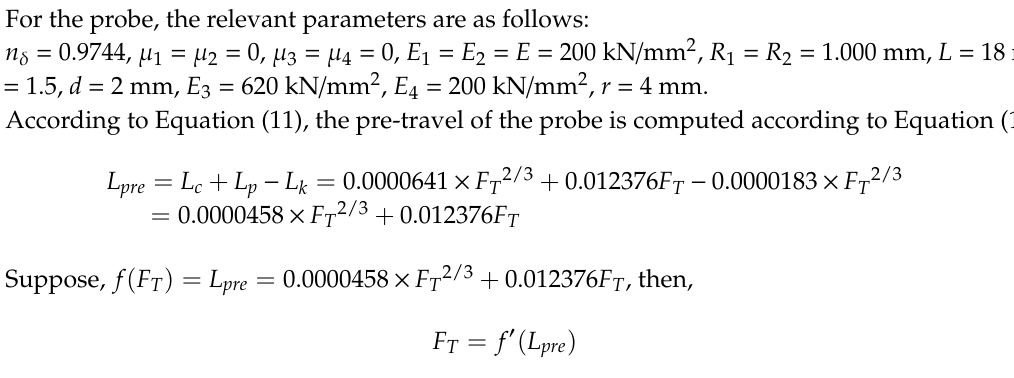
( c ) Figure 8. Error distribution of probe parameter calibration in different directions. ( a ) the repeatability error distribution of the trigger position of the probe; ( b ) the pre-travel distribution of the probe; ( c ) the measurement force distribution of the probe at the moment of trigger.